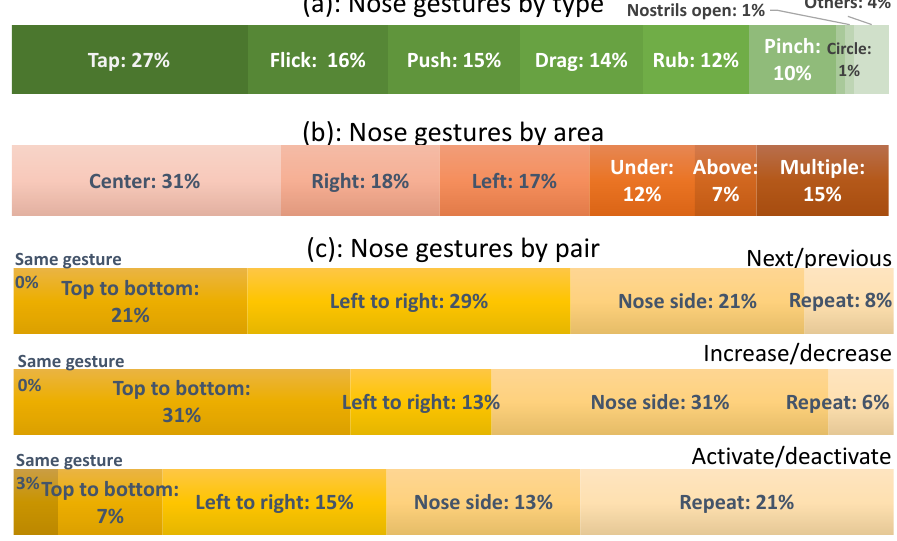
Figure 5. Distribution: ( a ) by type, ( b ) by area, ( c ) by